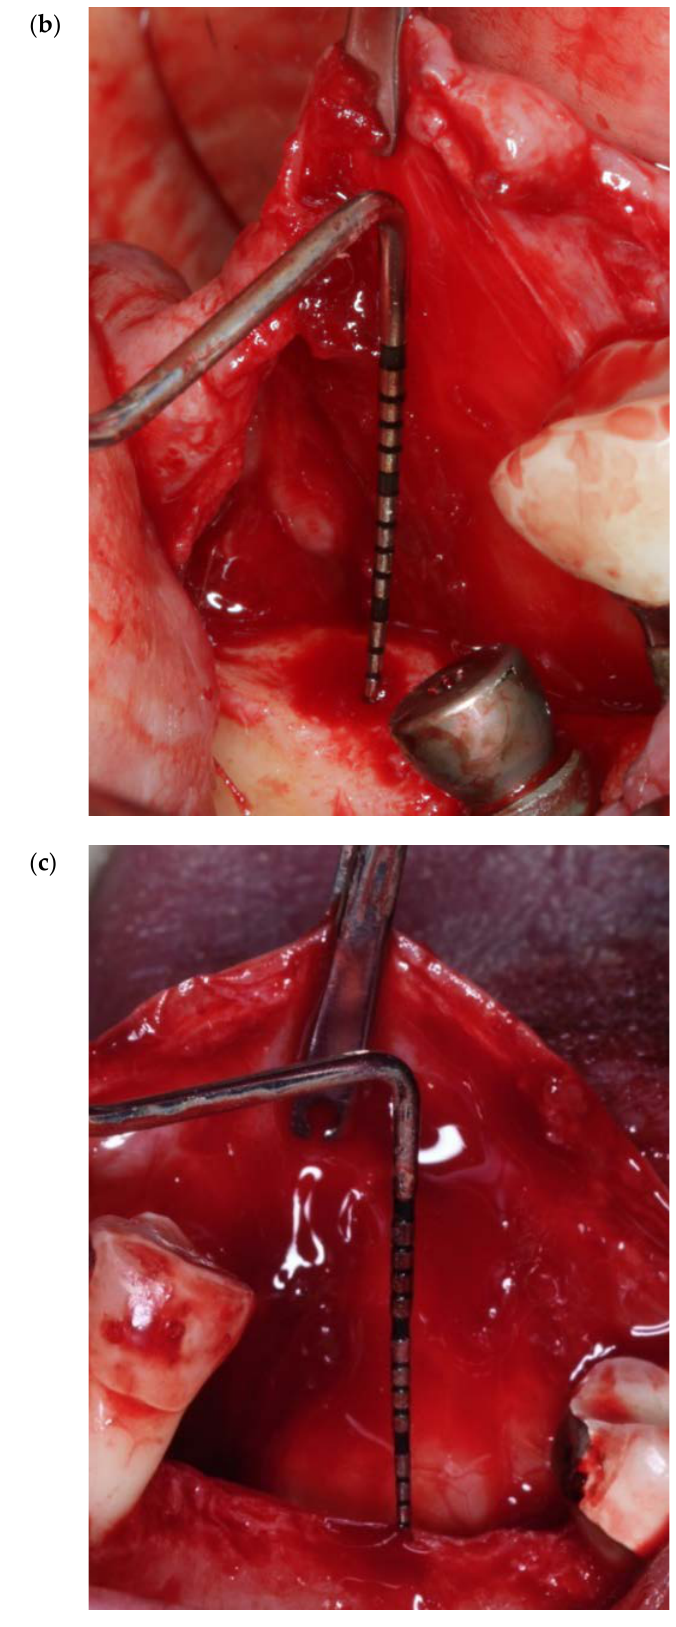
Figure 6. ( a – c ) Clinical view of MMR in a vertical direction, ranging from 29–32 mm.